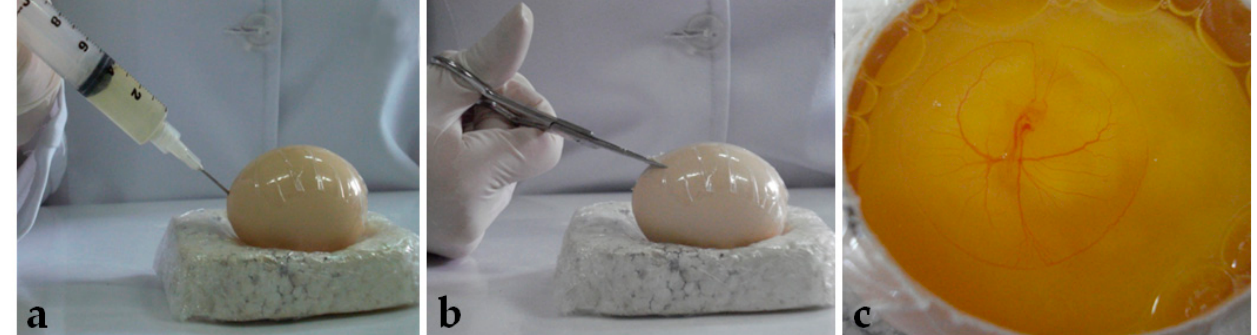
Figure 1. Egg opening: ( a ) Removing of albumen. ( b ) Window opening. ( c ) Embryo visualization. Embryos were considered alive if they were bright rose-colored, presented heartbeats, and had intact extraembryonic blood vessels (Figure 2a). Dead embryos presented a whitish and opaque vitelline membrane, absence of heartbeats, and non-intact